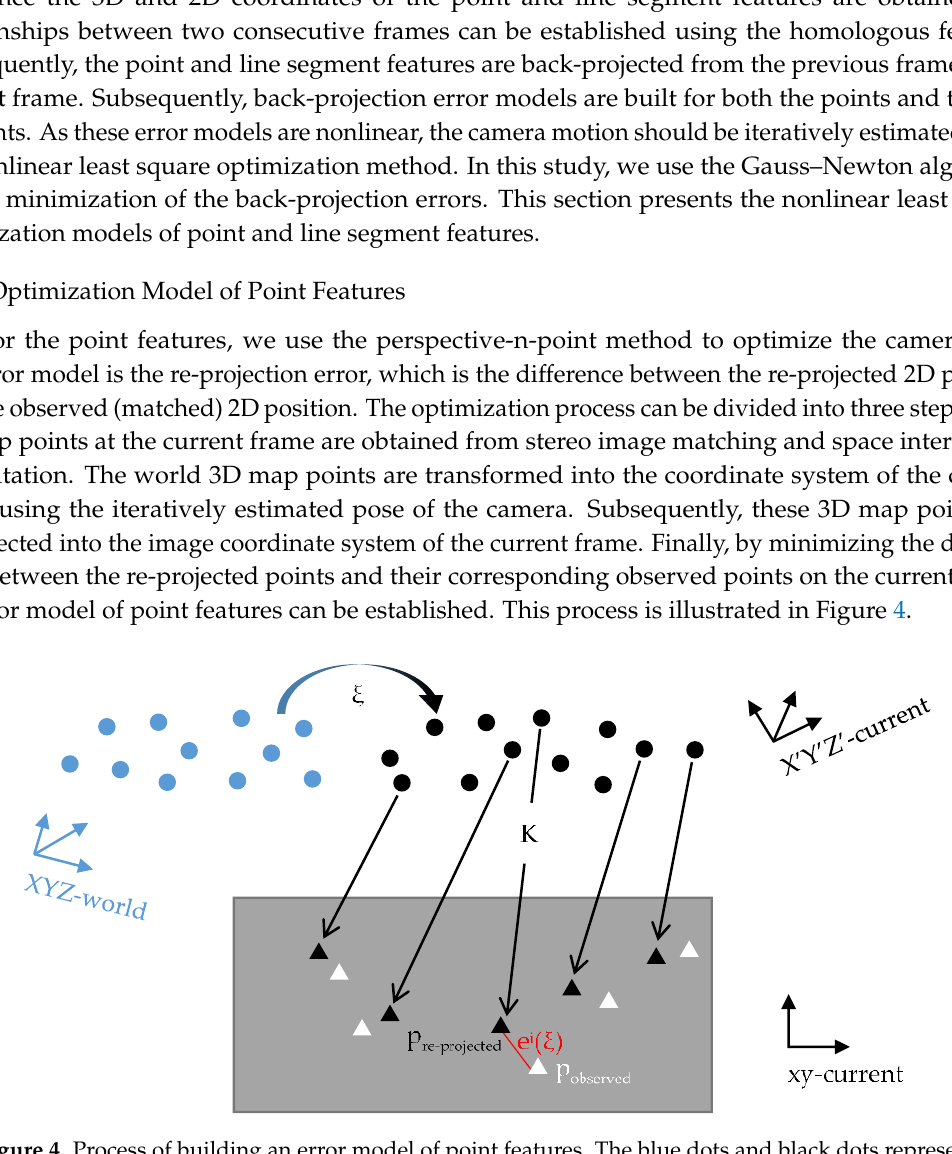
Figure 3. Common low-texture environment in an indoor scene with white walls, and point features (green x marks) extracted using ORB algorithm and line segment features (red lines) extracted using LSD algorithm.